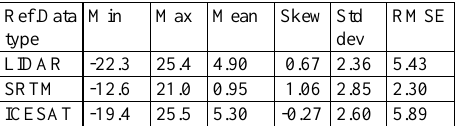
Table 3. Statistics with elevation difference between TanDEM- X and other reference data at 9000 selected point locations for Bihar test site.